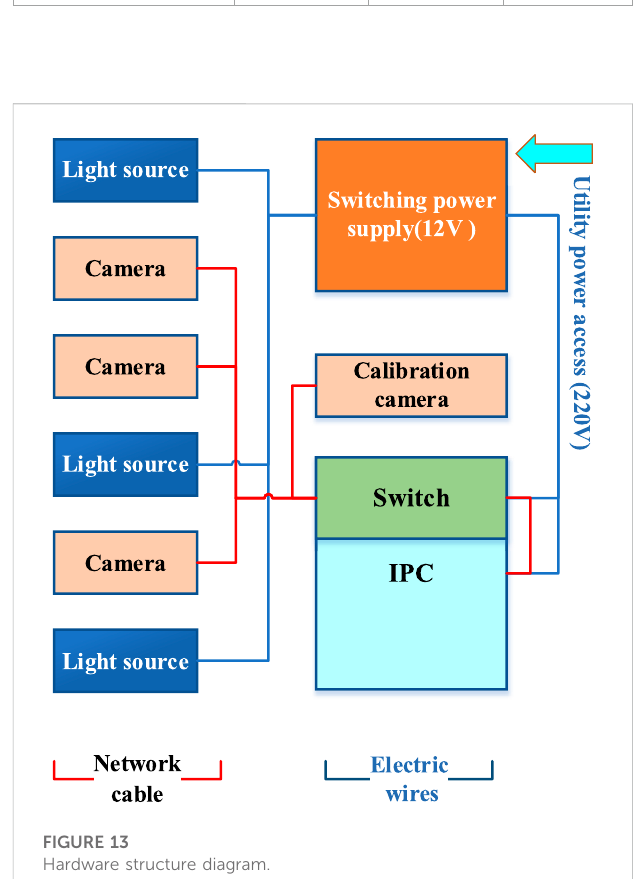
FIGURE 13 Hardware structure